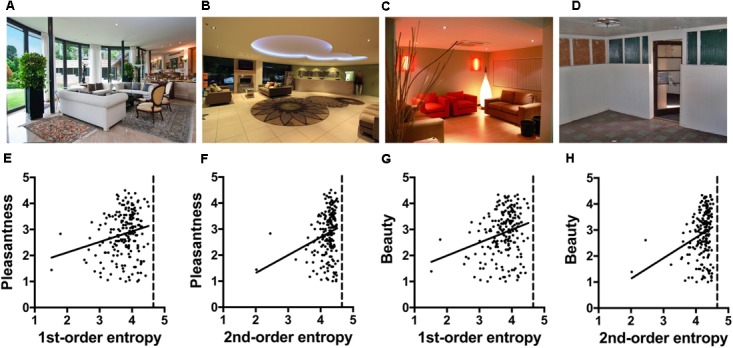
(A–D) Examples of the interior scene photographs (Vartanian et al., 2013; Experiment 4). The values for the image properties calculated for each image are listed in Supplementary Table S3. (E–H) Dot plots of 1st-order entropy (E,G) and 2nd-order entropy (F,H)
versus the ratings for pleasantness
(E,F) and beauty
(G,H), averaged across participants. Each dot represents the results for one image. The straight lines indicate the results from simple regression analyses (E, R2 = 0.043; F[1,198] = 8.99, p = 0.0031; F, R2 = 0.053; F[1,198] = 11.17, p = 0.0010; G, R2 = 0.065; F[1,198] = 13.68, p = 0.0003; H, R2 = 0.070; F[1,198] = 14.80, p = 0.0002). The images in (A–D) were reproduced with kind permission from Dr. O. Vartanian.